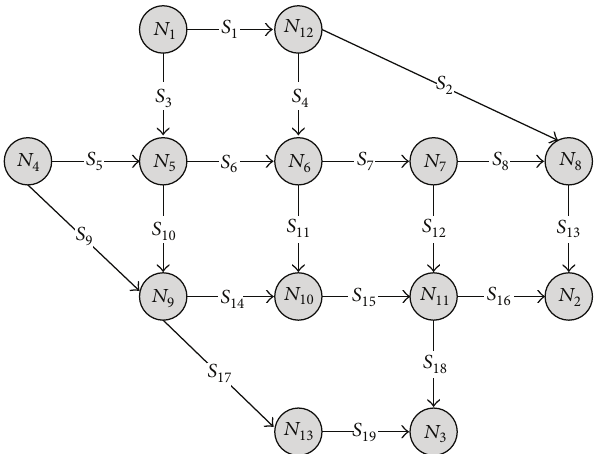
Figure 1: An example of transit